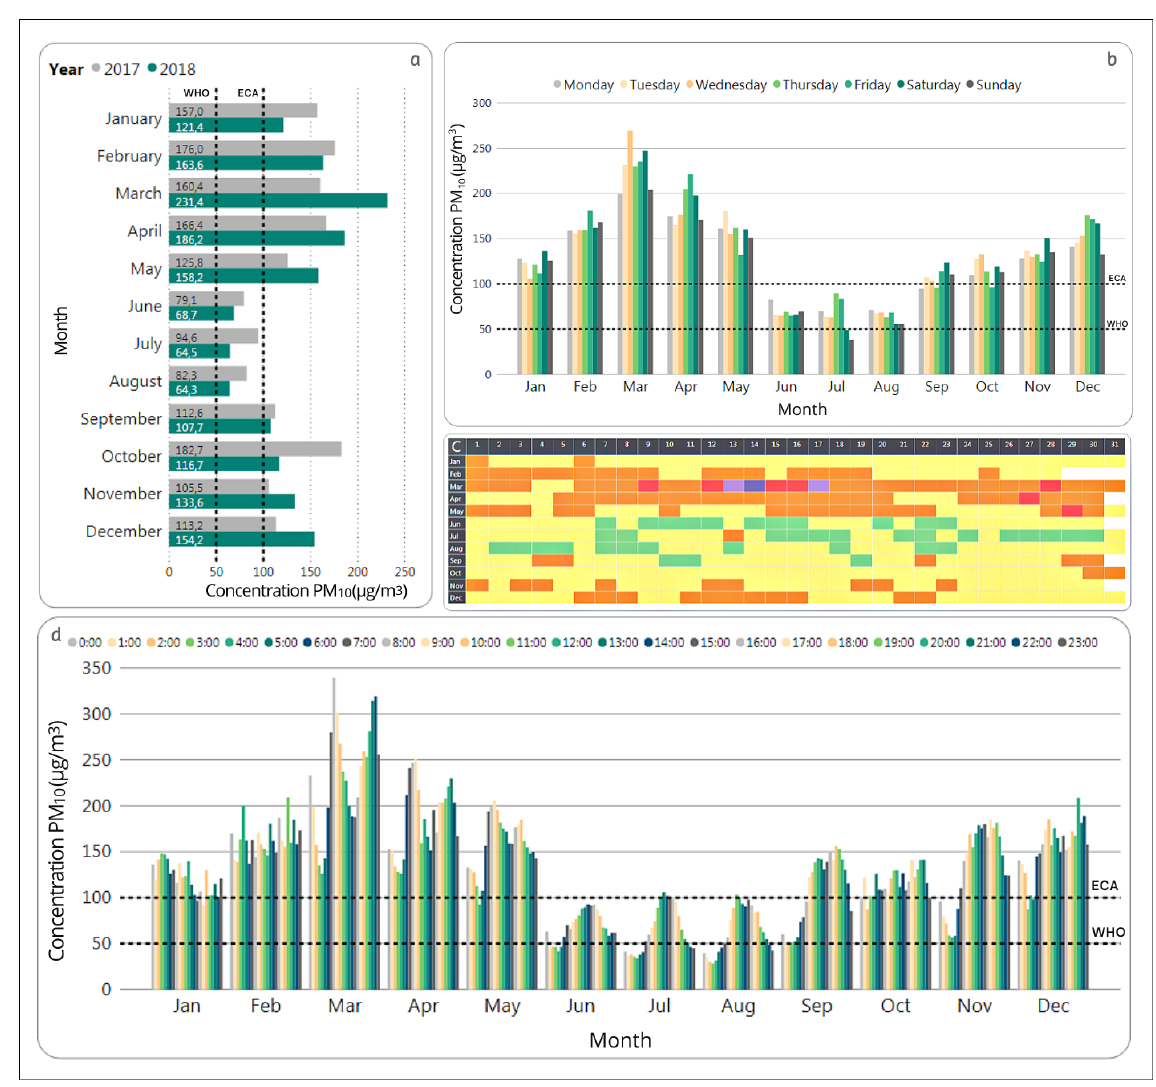
Figure 6. ( a ) Monthly comparison of PM 10 concentration in the period 2017–2018 for the HCH station. ( b ) Daily variation of PM 10 concentration per month in the year 2018 for the HCH station. ( c ) 2018 heat table at the HCH station. ( d ) Hourly variation of the PM 10 concentration per month in 2018 for the HCH